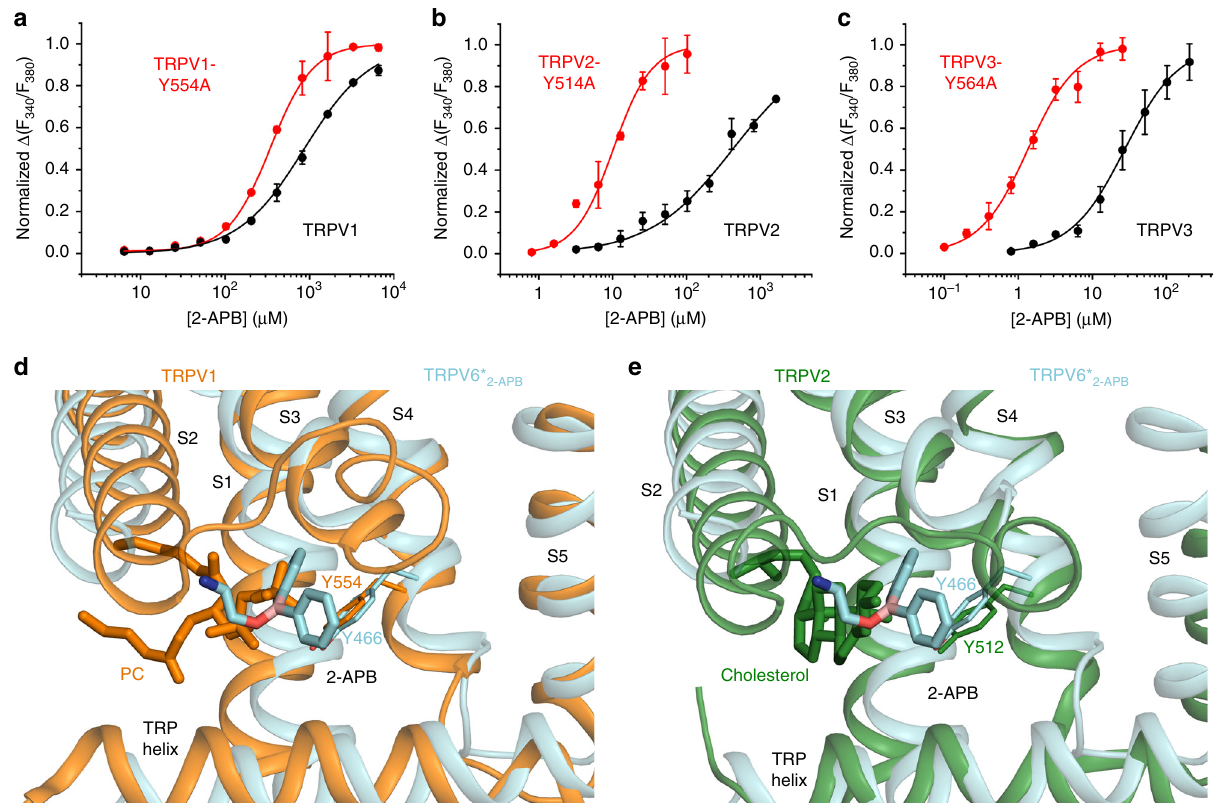
Fig. 5 Probing of the 2-APB binding site in different TRPV channels. a – c Dose – response curves for 2-APB activation of wild-type (black) and mutant (red) rat TRPV1 ( a ), rat TRPV2 ( b ), and mouse TRPV3 ( c ) channels with alanine substitution of the conserved tyrosine in the presumed 2-APB binding pocket. Each data point represents an average of n = 3 – 7 measurements with error bars representing SEMs. d , e Close-up view of superposition of the 2-APB binding pocket in the TRPV6* 2-APB crystal structure (cyan) and the corresponding regions of rat TRPV1 ( d ) PDB ID: 5IRX, orange and rabbit TRPV2 ( e ) PDB ID: 5AN8, green. Phosphatidylcholine (PC), cholesterol and 2-APB molecules as well as the side chain of the conserved tyrosine are shown as